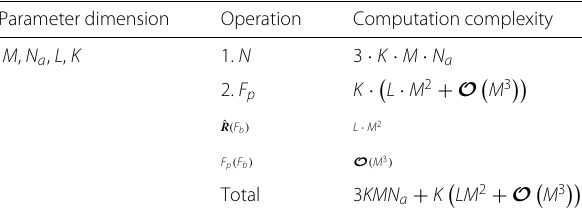
Table 2 Relevant parameters of the azimuth six-channel SAR system for simulation experiments